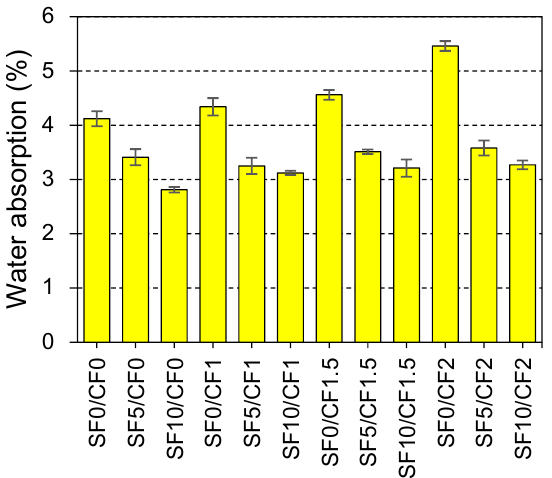
Figure 15. Effect of silica fume and coir reinforcement on the water absorption capacity of HSC.